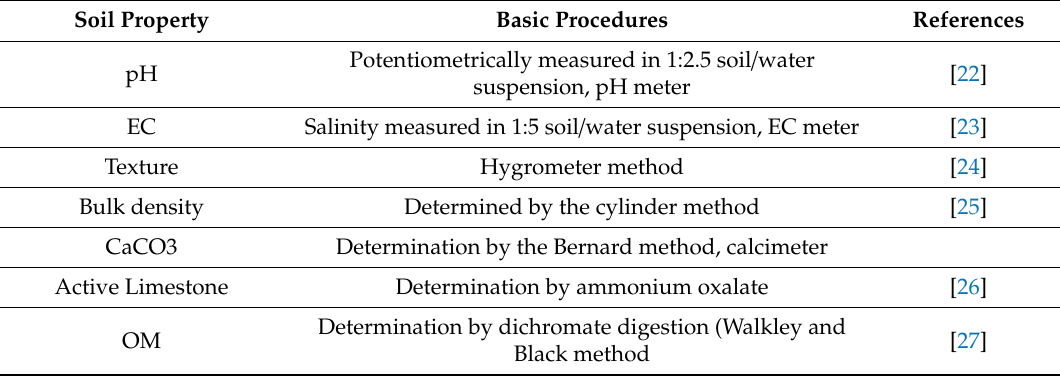
Table 1. Procedures for physiochemical characterization of soil samples from the study